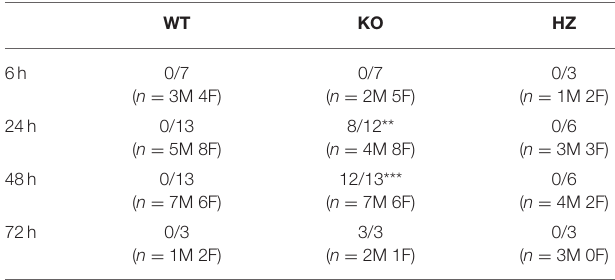
72h 0/3 ( n = 1M 2F) The results are represented as ratio of bacteremic mice/total number of infected mice. Fisher’s exact test. *** p < 0.001, ** p < 0.005. M, male; F, female.